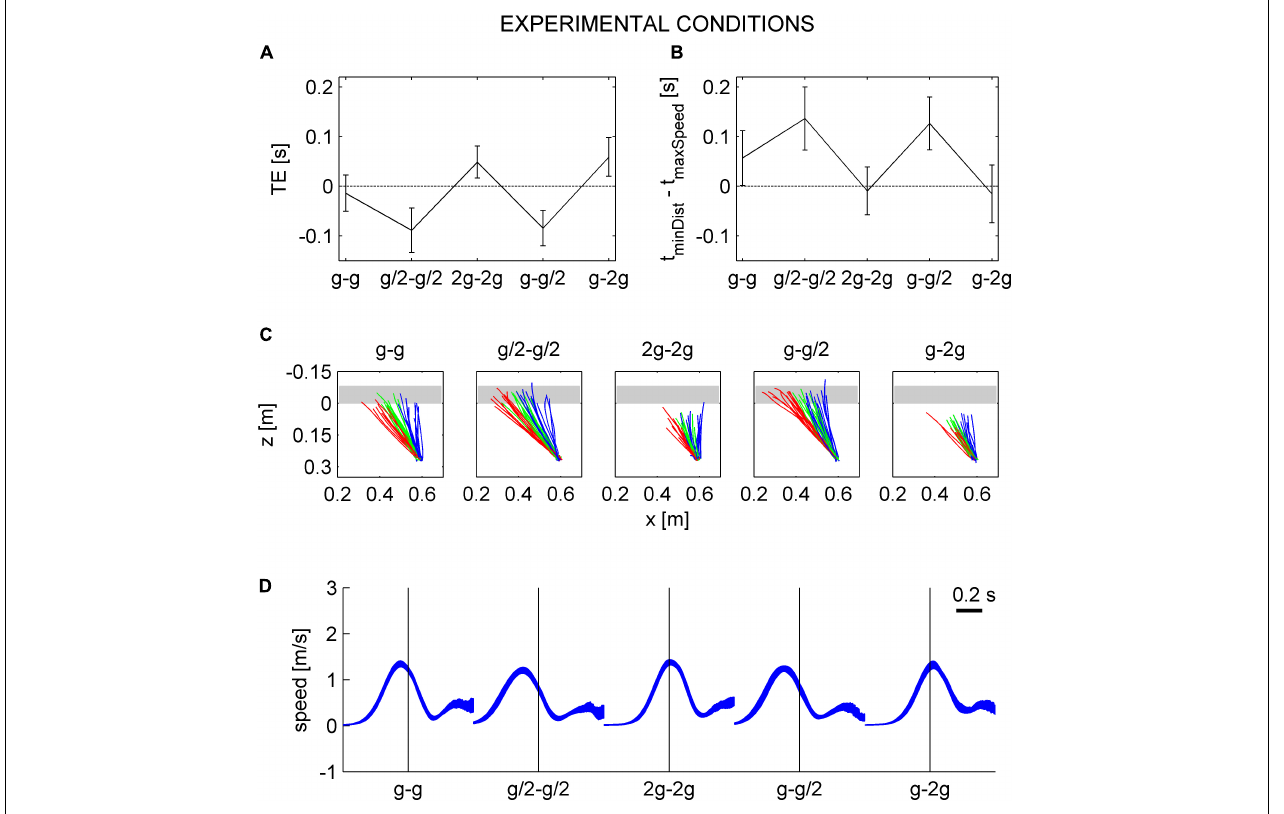
FIGURE 8 | Timing errors and hand movement characteristics. (A) Timing errors (mean ± 95% confidence interval, three traveled distances × two visual conditions × 16 subjects, n = 96). (B) Intervals (mean ± 95% confidence interval, three traveled distances × two visual conditions × 16 subjects, n = 96) between the time at which the hitter arrived in IP and the time of maximum hitter speed. (C) Top view of hitter trajectories for all repetitions ( n = 12) of a representative participant (#13) for each gravity condition and traveled distance (red 0.564 m, green 1.093 m, and blue 2.186 m) in the occluded session. The trajectories are plotted from the starting position to IP. Gray area represents the envelope of ball trajectory. (D) Speed profiles of hitter movements of the same subject of C . The 95% confidence interval over all repetitions and traveled distances in the occluded session are plotted for each gravity condition. Traces are aligned on the hitter arrival time in IP (vertical